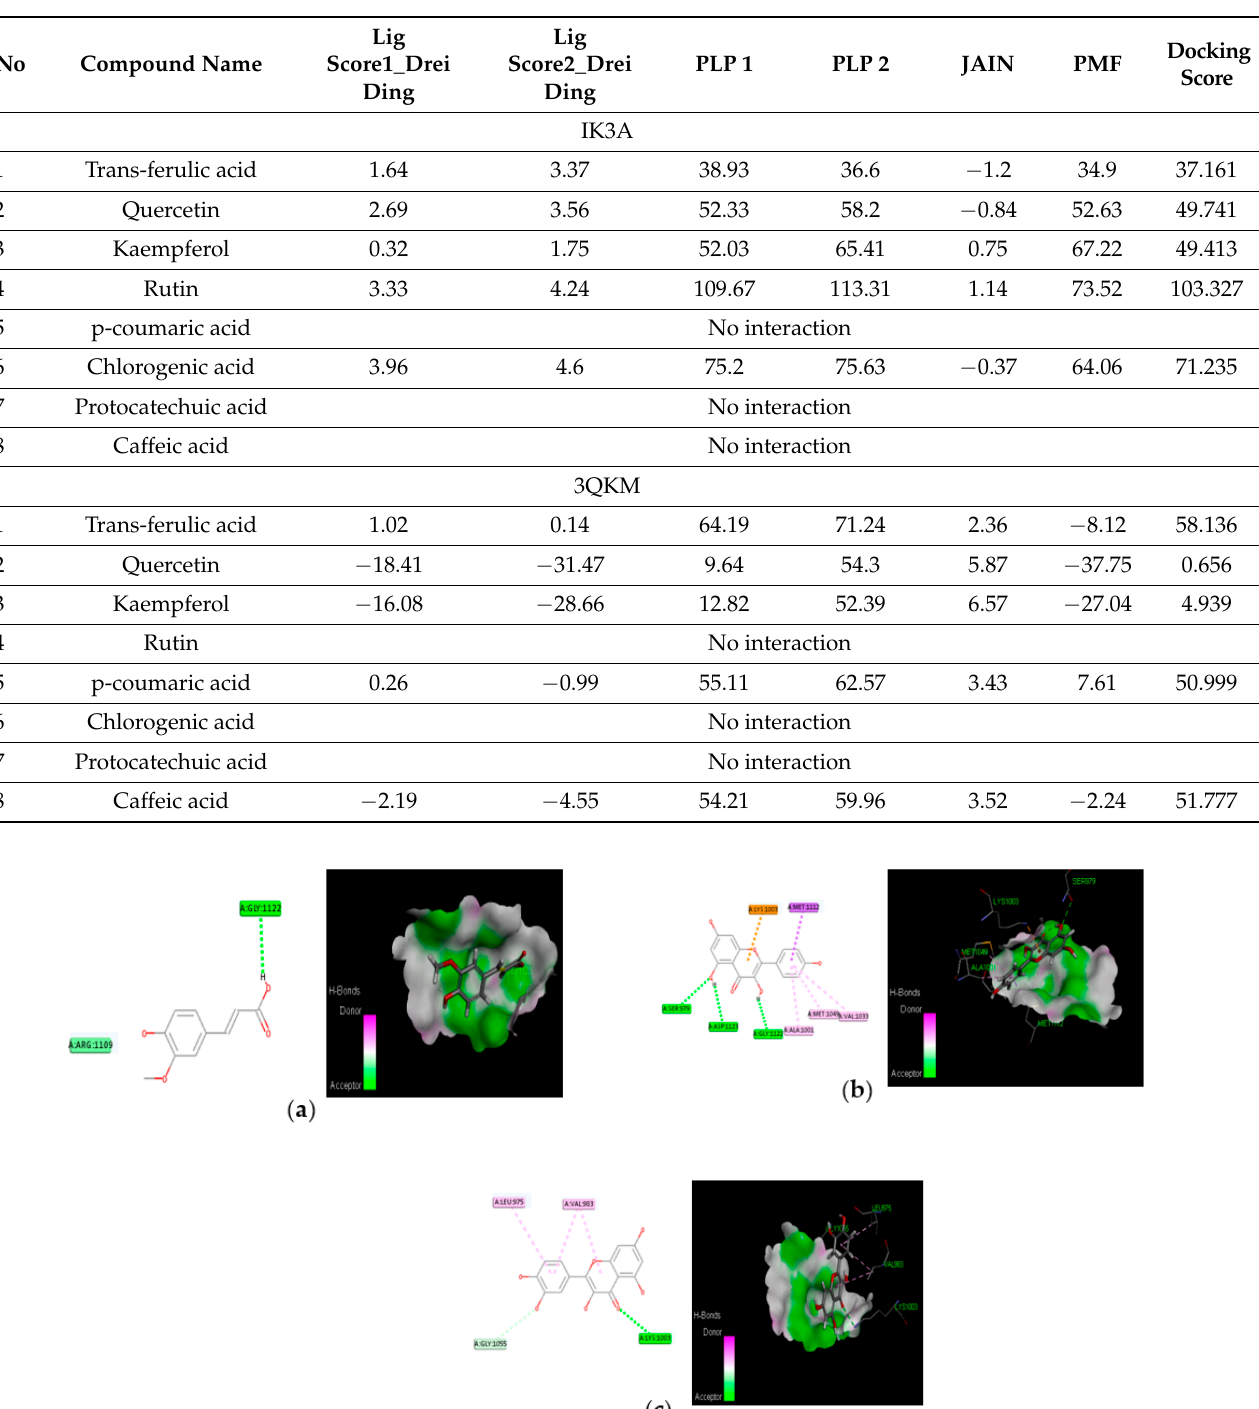
Figure 7. Molecular interaction of best three compounds with Akt; ( a ) p-coumaric acid; ( b ) caffeic acid; ( c ) trans-ferulic acid.